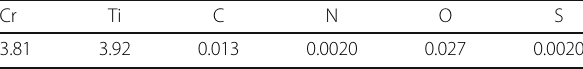
Table 1 Chemical composition of main elements and impurities in V-4Cr-4Ti alloy